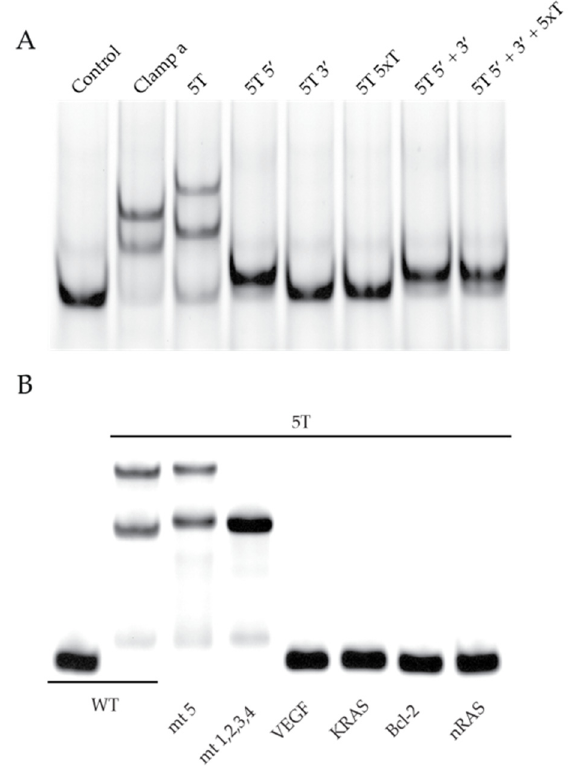
Figure 5. DNAi 5T selectivity and specificity for MYC G4 1-4 . ( A ) 5T binding to WT Pu46 was compared to clamp a and to its partitioned components. 5T shifting was similar to that of clamp a, albeit heavier due to the five thymes, as compared to the abasic linker. Notable recognition of Pu46 was not evident with any component of 5T. ( B ) FAM-labeled 5T was used to examine binding to an array of G4-forming sequences, including those from the MYC (WT and MT5, as well as the non-G4-forming MT1,2,3,4), VEGF, KRAS, Bcl-2, and nRAS promoters were examined. Table 1. Intranuclear accumulation of DNAi in RAJI cells.